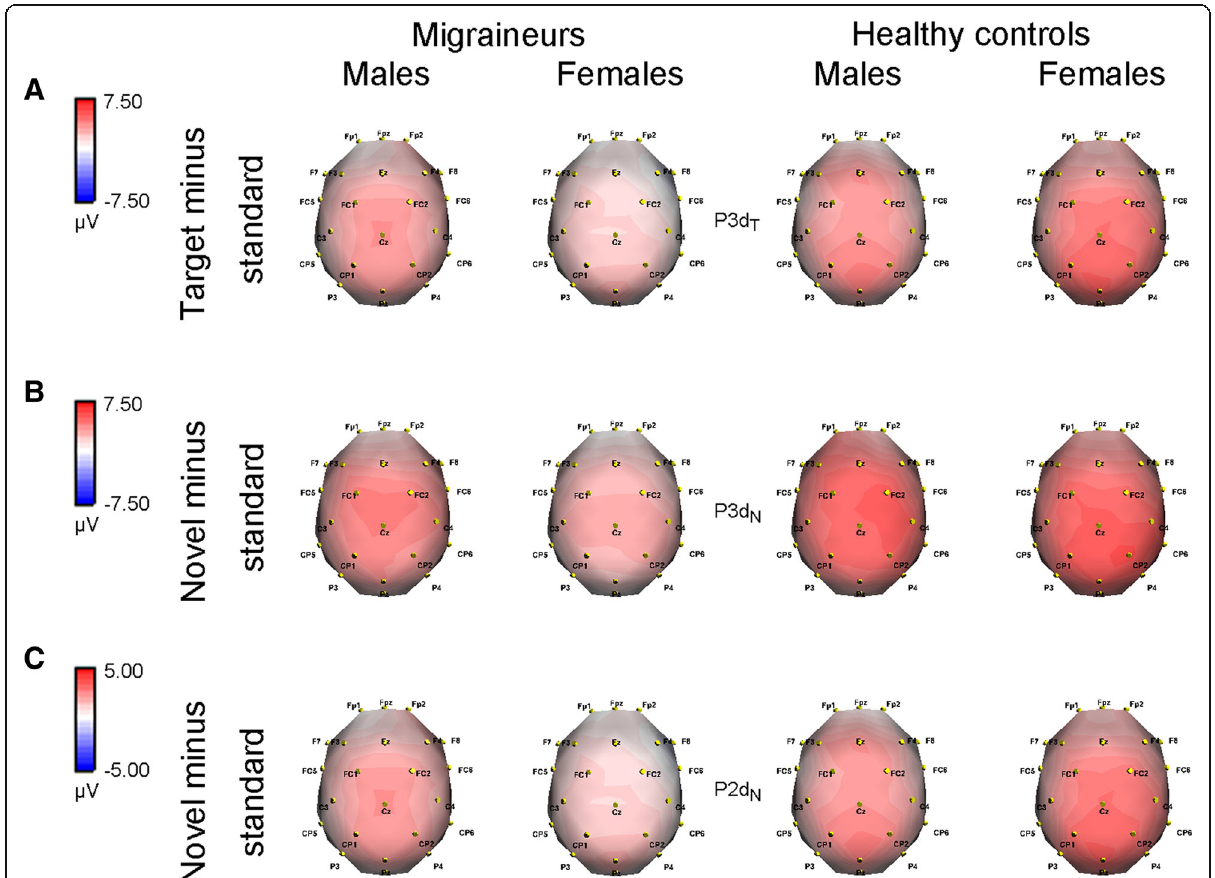
Fig. 4 Topographical voltage distributions of difference ERP components in migraineurs and healthy controls, respectively. a P3d T at 410 – 430 ms; ( b ) P3d N at 380 – 400 ms; ( c ) P2d N at 160 – 180 ms. P3d T , P3d N and P2d N represent the P3 target effect (target minus standard), P3 and P2 novel effects (novel minus standard), respectively. Red color denotes a positive and blue color a negative